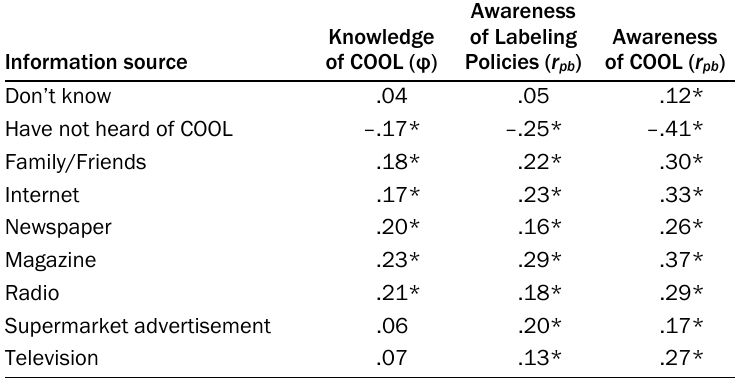
Table 5. Relationships Between Knowledge/Awareness and Information Sources Used for